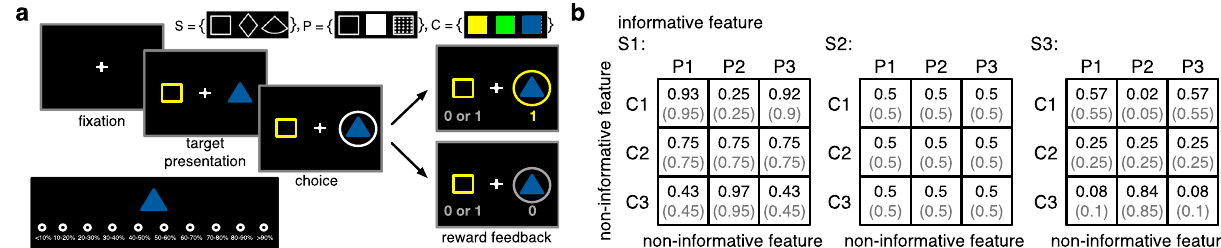
Fig. 1 Experimental procedure. a Timeline of a choice trial during the multi-dimensional probabilistic learning task. In each choice trial, the participants chose between two stimuli (colored patterned shapes) and were provided with reward feedback (reward or no reward) for both the chosen and unchosen stimuli. The inset at the top shows the set of all visual features used in the experiment (S: shape; P: pattern; C: color). The inset at the bottom shows the screen during a sample estimation trial. In each estimation trial, the participants provided their estimate about the probability of reward for the presented stimulus by pressing 1 of 10 keys (A, S, D, F, G, H, J, K, L, and;) on the keyboard. b Example of reward probabilities assigned to 27 possible stimuli. Stimuli were de fi ned by combinations of three features, each with three instances. Reward probabilities were non-generalizable, such that reward probabilities assigned to all stimuli could not be determined by combining the reward probabilities associated with their features or conjunctions of their features. Numbers in parentheses demonstrate the actual probability values used in the experiment due to limited number of trials. For the example schedule, the shape was on average informative about reward (average probability of reward on three shapes were equal to 0.3, 0.5, and 0.7). Although pattern and color alone were not informative, the conjunction of these two non-informative features was on average informative about the reward. Each participant was randomly assigned to a condition where the informative feature was either pattern or shape.